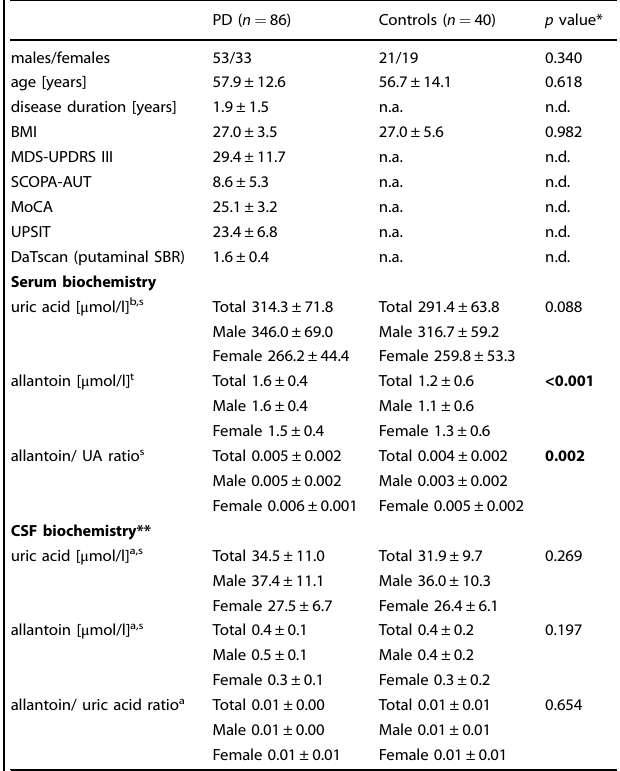
Table 1. Demographic data and results of biochemical